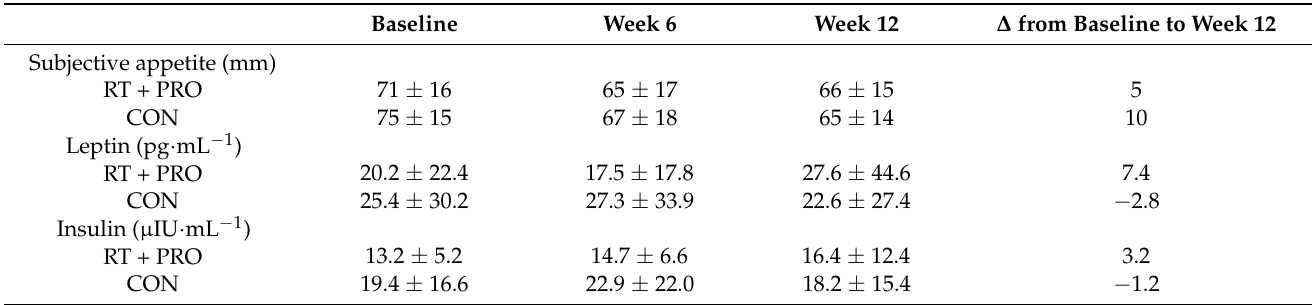
Table 3. Fasted subjective appetite sensations and circulating hormones concentrations at baseline, week 6 and Week 12 during the meal tolerance test in RT + PRO and